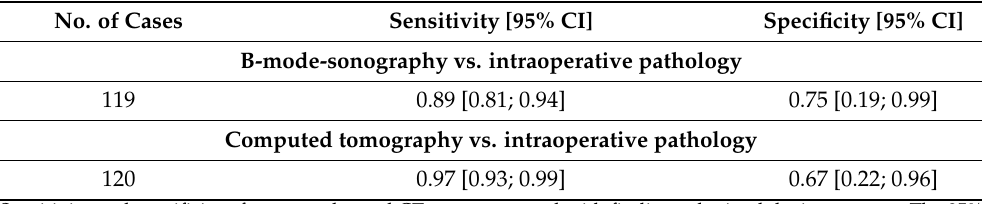
Table 2. Comparison of intraoperative pathology assessment B-mode US and CT imaging findings.